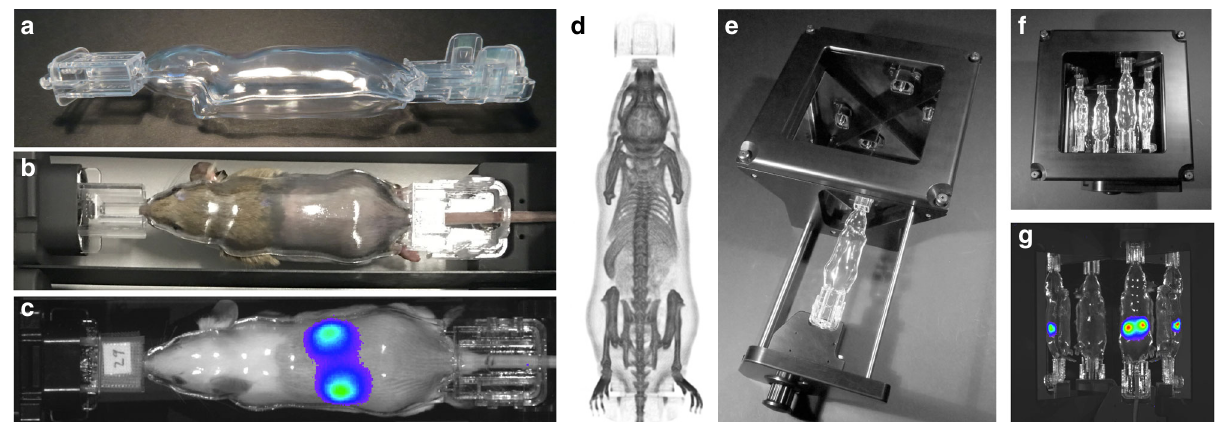
Fig. 3 Body-conforming animal mold and mirror gantry. BCAM provides known surface geometry for BLt and enables atlas coregistration. Mirror gantry provides multiview image of mouse for BLt. a Optically transparent BCAM consisting of top and bottom shell. b BCAM with combined gas anesthesia supply and gas scavenging port holds animal in an immobilized and geometrically de fi ned position and pose. c Bioluminescence image of animal with lux- bacteria in kidneys. d X-ray projection of mouse inside BCAM. e Mirror gantry for multiview imaging. f Photograph showing direct (dorsal) and re fl ected BCAM (ventral, left, right) views. g Multiview camera image of luminescent mouse shows dorsal, ventral, left, and right view of